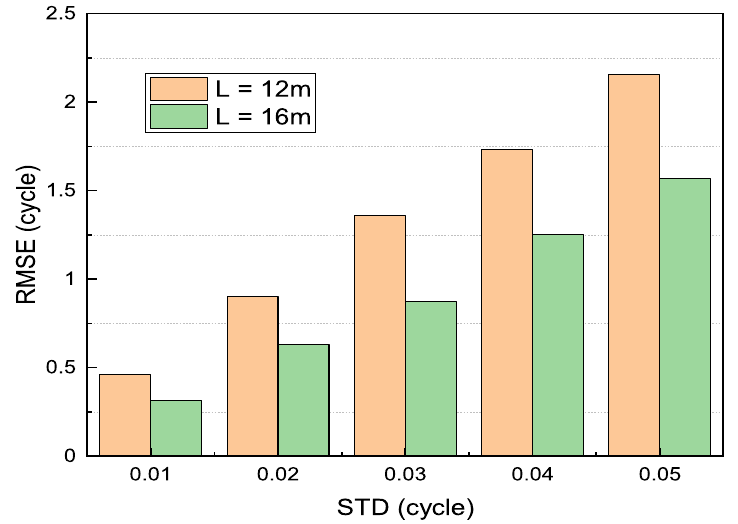
Figure 8. RMSE values of AR for line with different trajectory sizes.